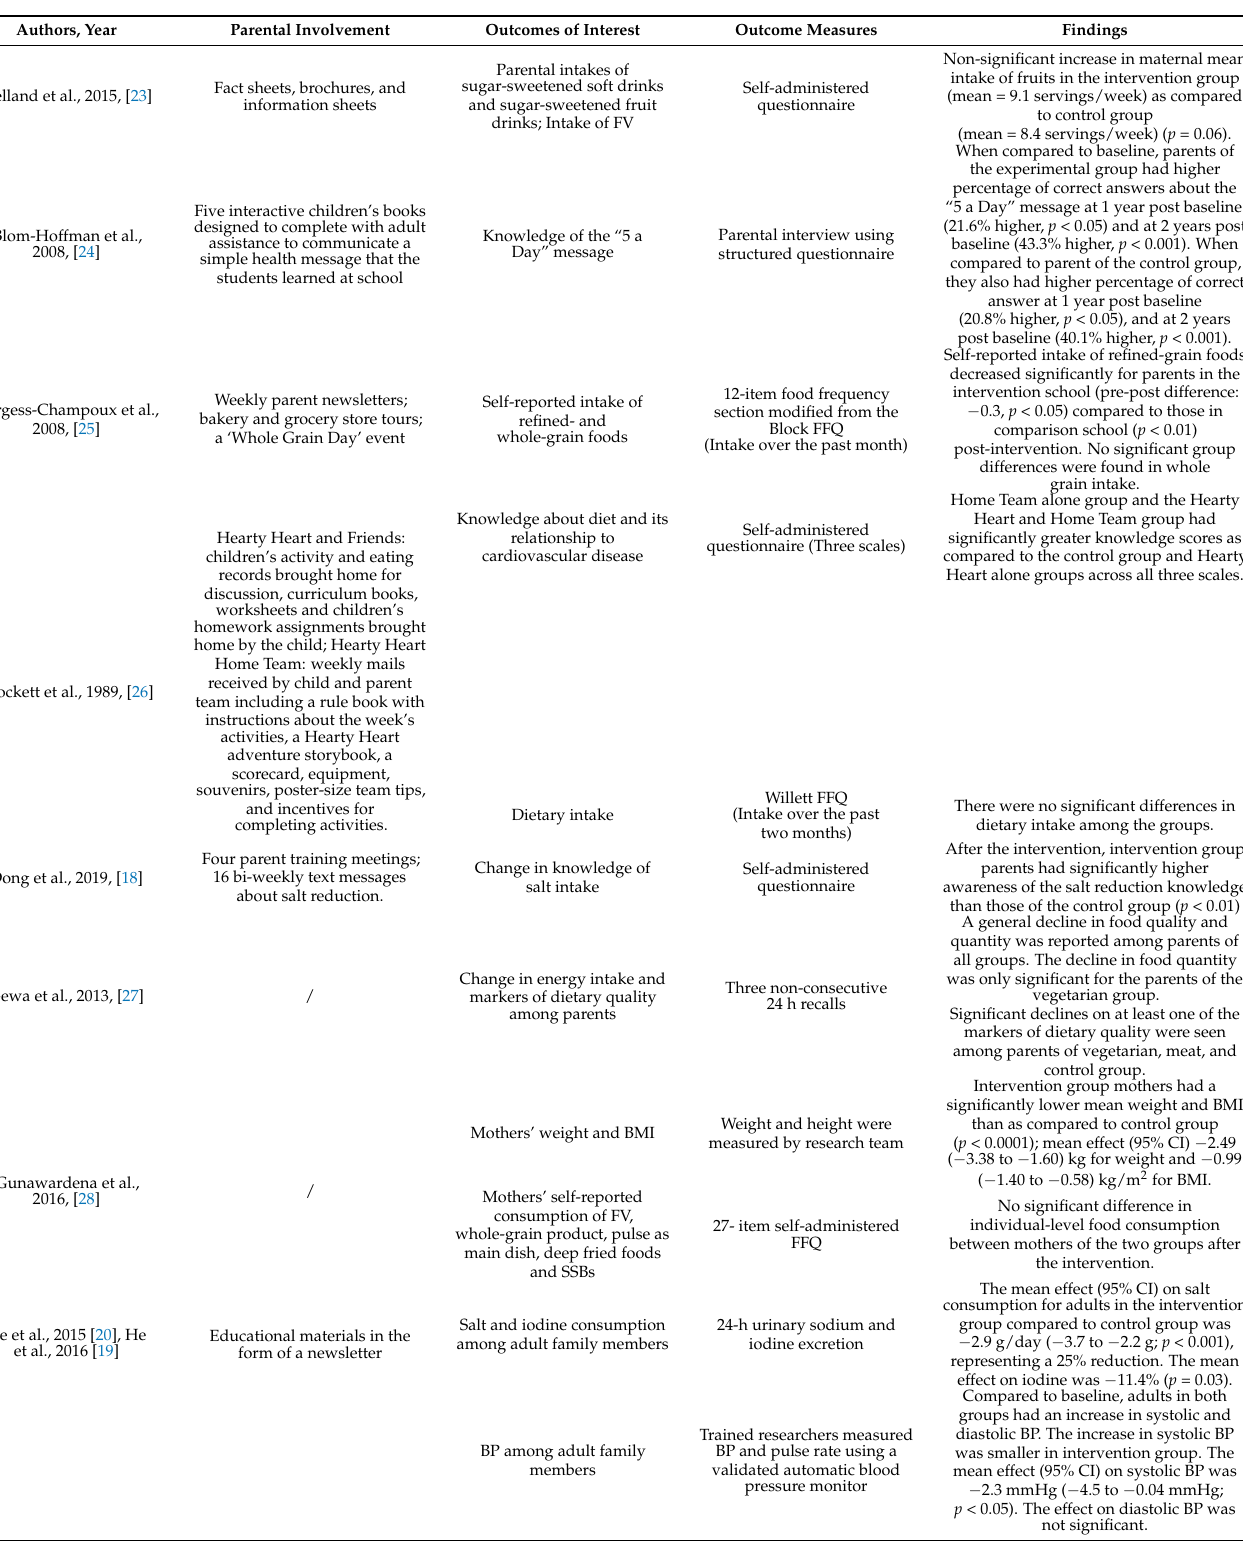
parental/family outcomes of